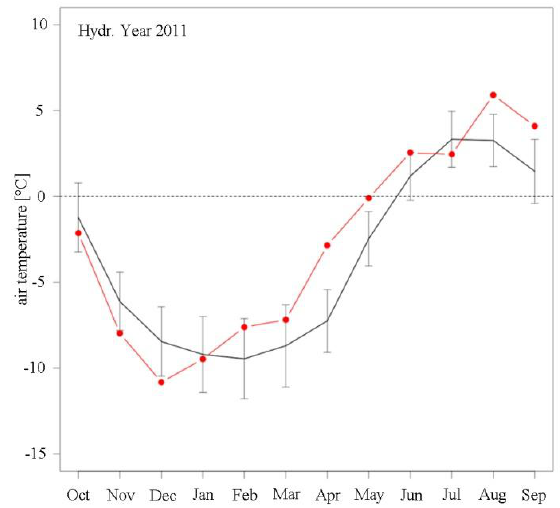
Figure 13 . Air temperature anomalies at 3100 m a.s.l. in the Matterhorn area (Italian side) during the hydrological year 418 Fig. 13. Air temperature anomalies at 3100m a.s.l. in the Matter- horn area (Italian side) during the hydrological year 2011. Com- 2011. Comparison between the monthly mean air temperature recorded from October 2010 to Sepember 2011 (red line) and 419 parison between the monthly mean air temperature recorded from the long-term climatic means of the period 1961-1990 (black line). The vertical lines represent the standard deviation for 420 October 2010 to September 2011 (red line) and the long-term cli- matic means of the period 1961–1990 (black line). The vertical lines each month. 421 represent the standard deviation for each